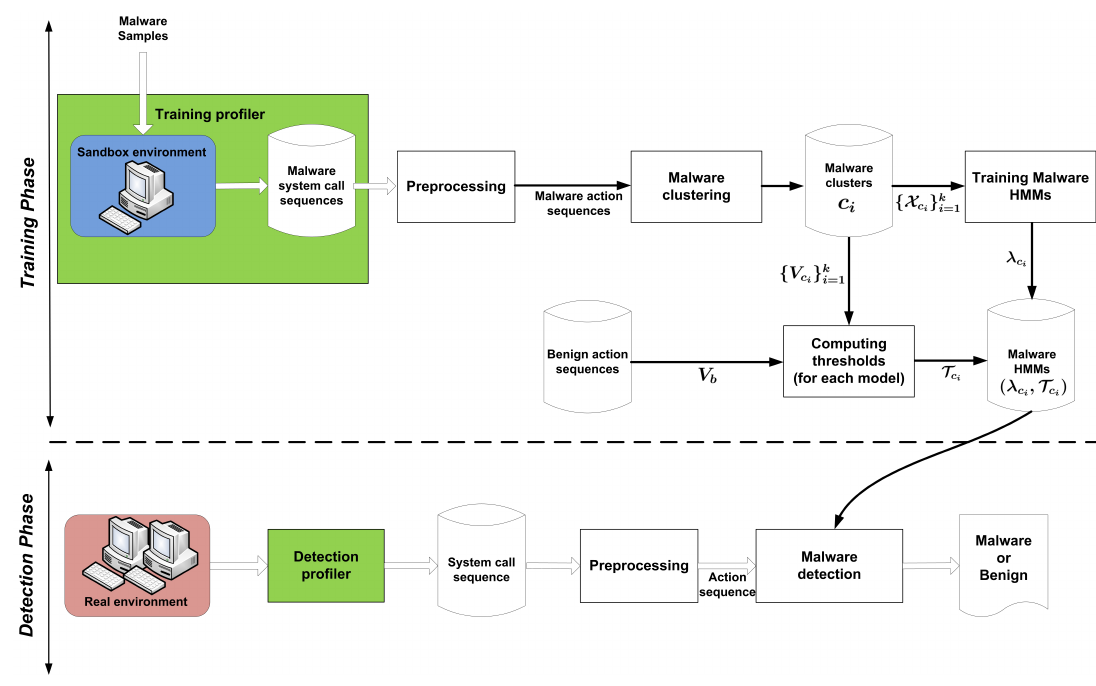
Figure 1. The architecture of HM 3 alD